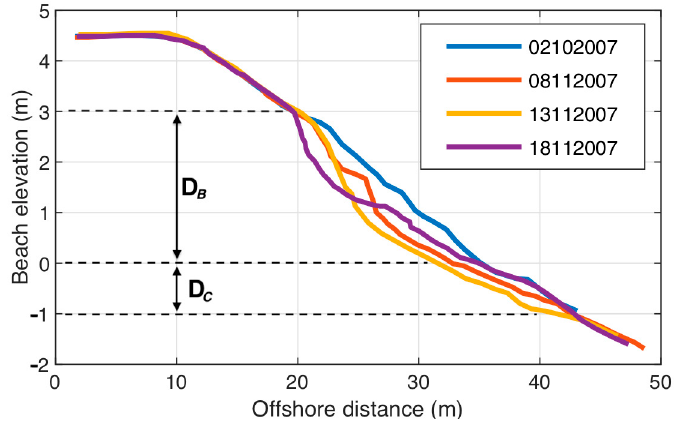
Figure 13. Surveyed cross-shore beach profile at Milford-on-Sea.